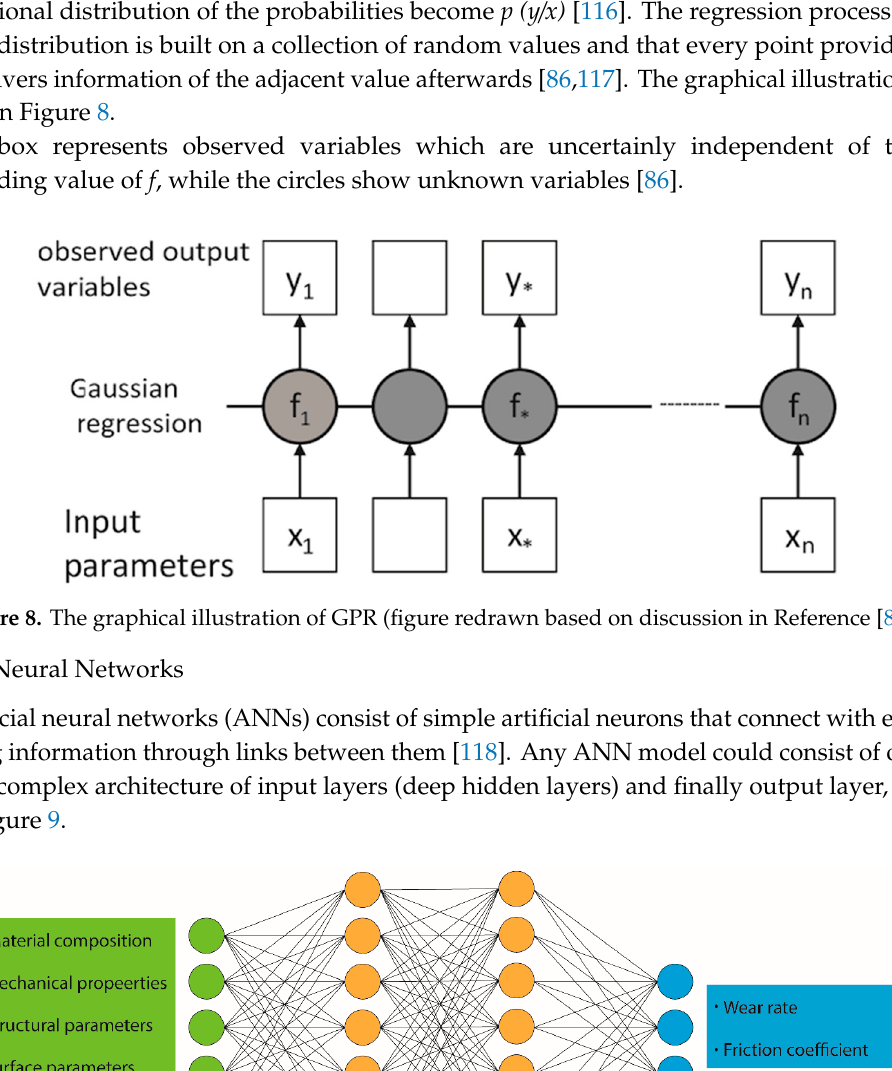
Table 1. Literature survey on simulation methods used to model and predict lubrication effect on tribology.